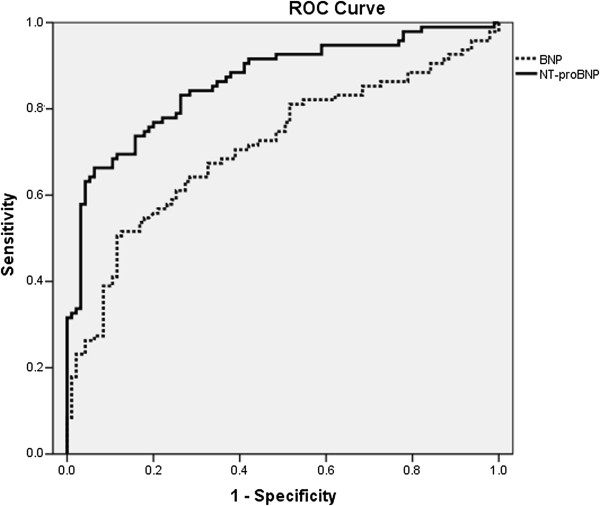
Entire study group ROC curve of BNP and NT-proBNP for heart failure. The area under the curve for BNP and NT-proBNP was 0.70 and 0.86 respectively.